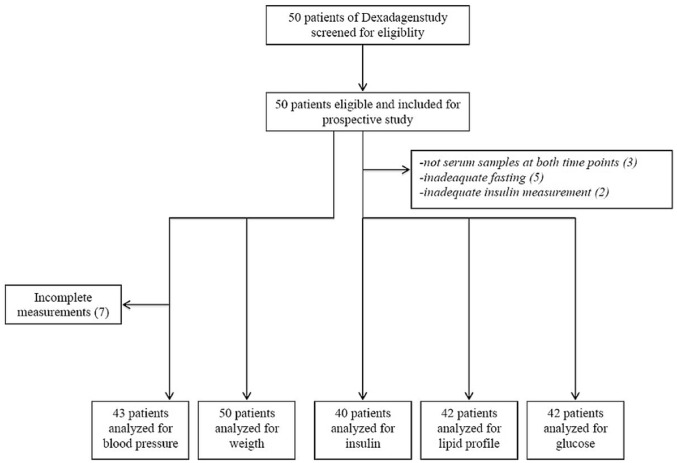
Consort flowchart.